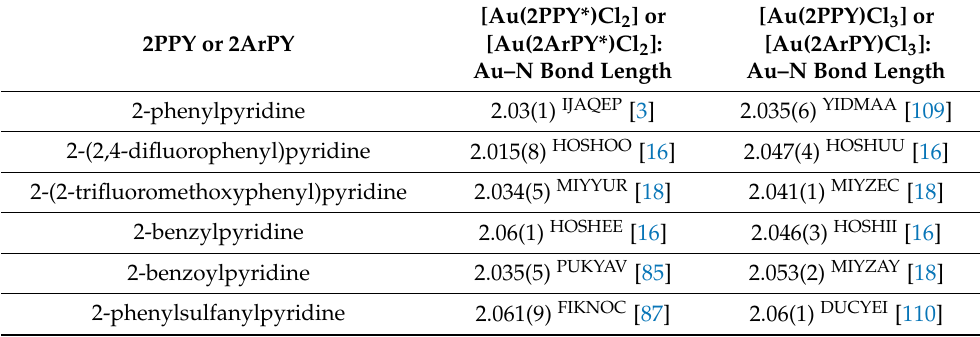
Table 8. Au–N bond lengths [Å] in analogous [Au(2PPY*)Cl 2 ] or [Au(2ArPY*)Cl 2 ] and [Au(2PPY)Cl 3 ] or [Au(2ArPY)Cl 3 ]